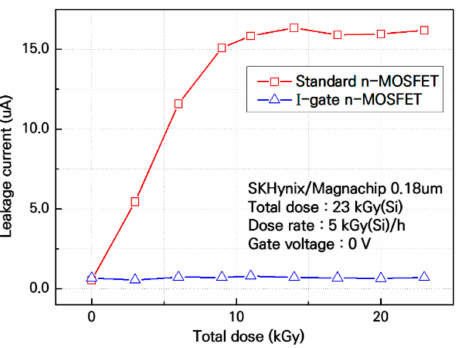
Figure 7. Measurement results of leakage current with respect to the cumulative radiation dose in the standard n-MOSFET and the I-gate